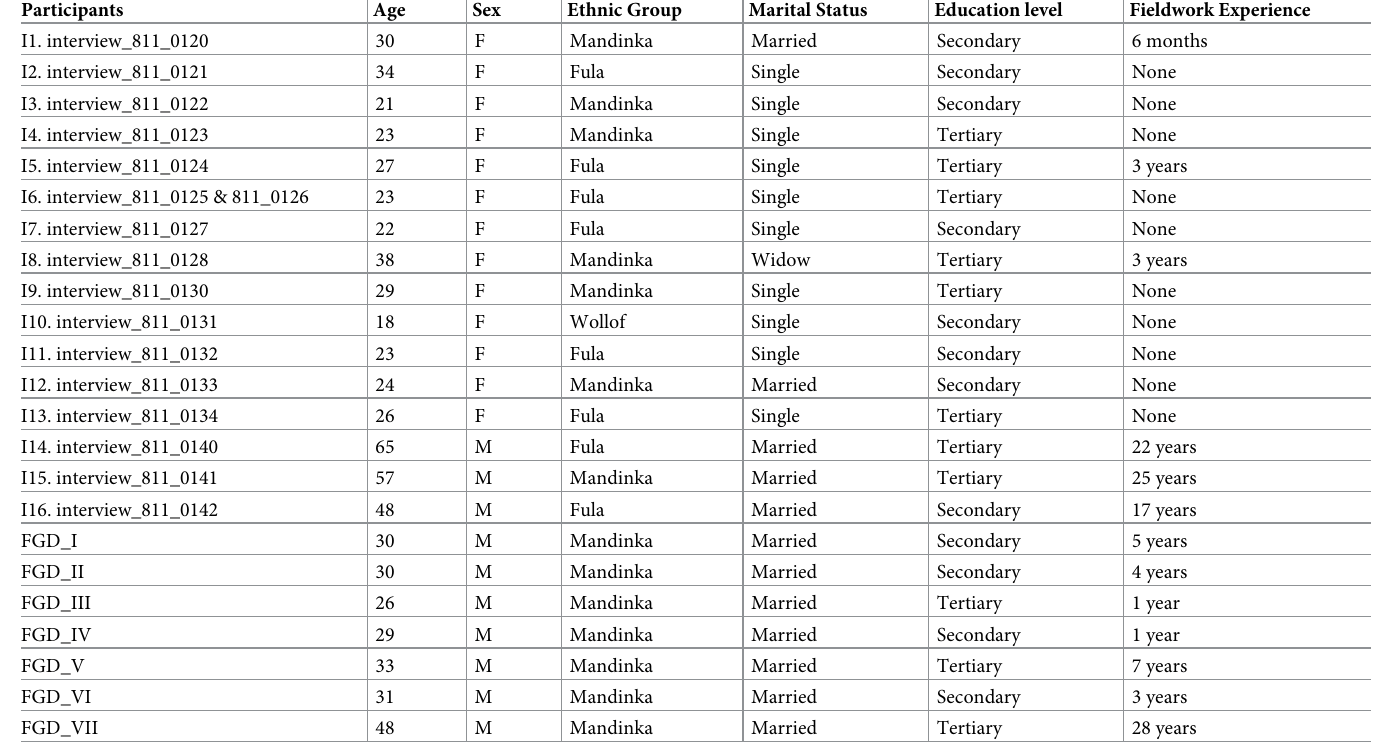
Table 1. Demographic profile of the study